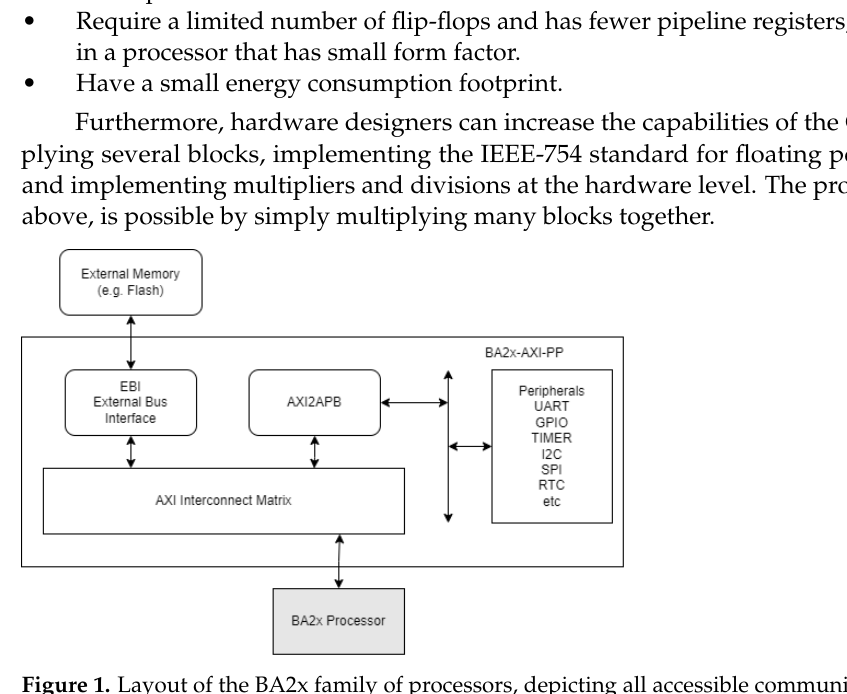
Figure 1. Layout of the BA2x family of processors, depicting all accessible communication lines and peripheral processing units